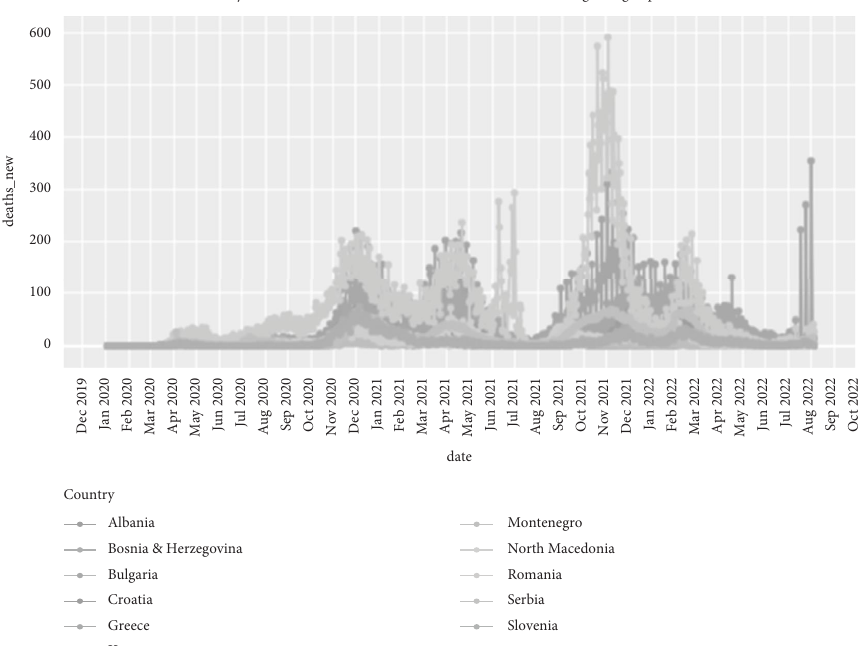
Figure 2: Daily COVID-19 fatalities in Balkan countries since the pandemic